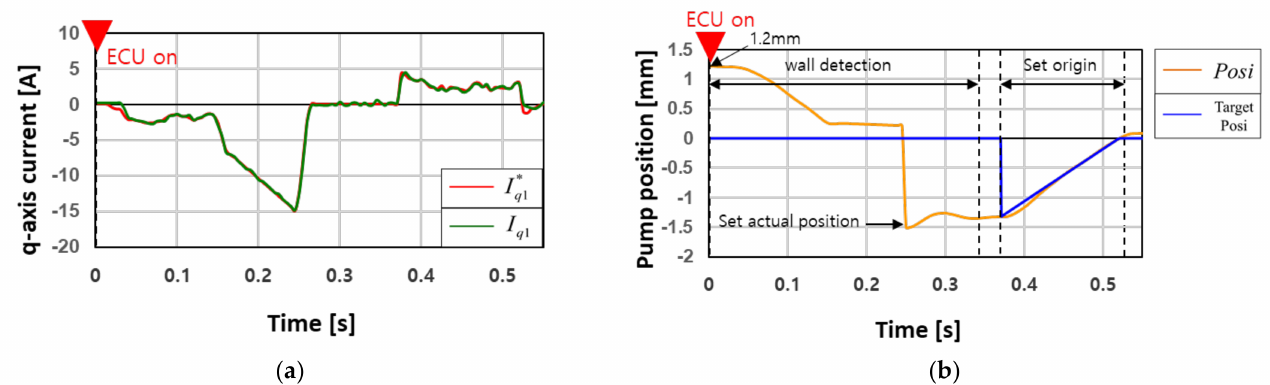
Figure 12. Measurement results regarding wall detection and origin set. process with the ECU on: ( a ) q − axis current command value ( I ∗ piston position and calculated pump piston